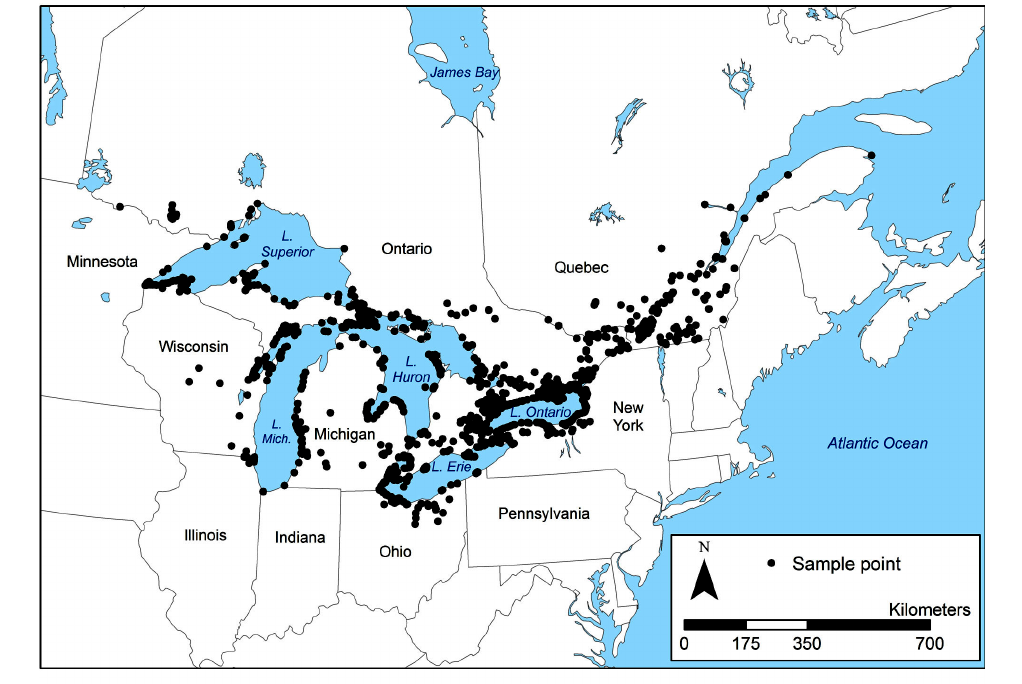
Fig. 1 . Locations of 3701 sample points used to assess the influence of call broadcast timing within point counts and survey duration on detection probability of marsh breeding birds throughout the Great Lakes–St. Lawrence region, 2008–2016. Note that for clarity, in most cases, each point represents more than one sample